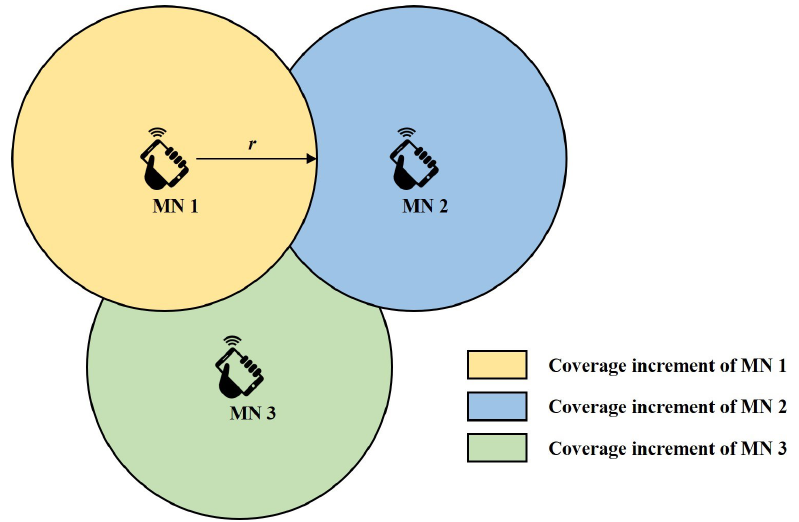
Figure 2. An example to illustrate the concept of coverage